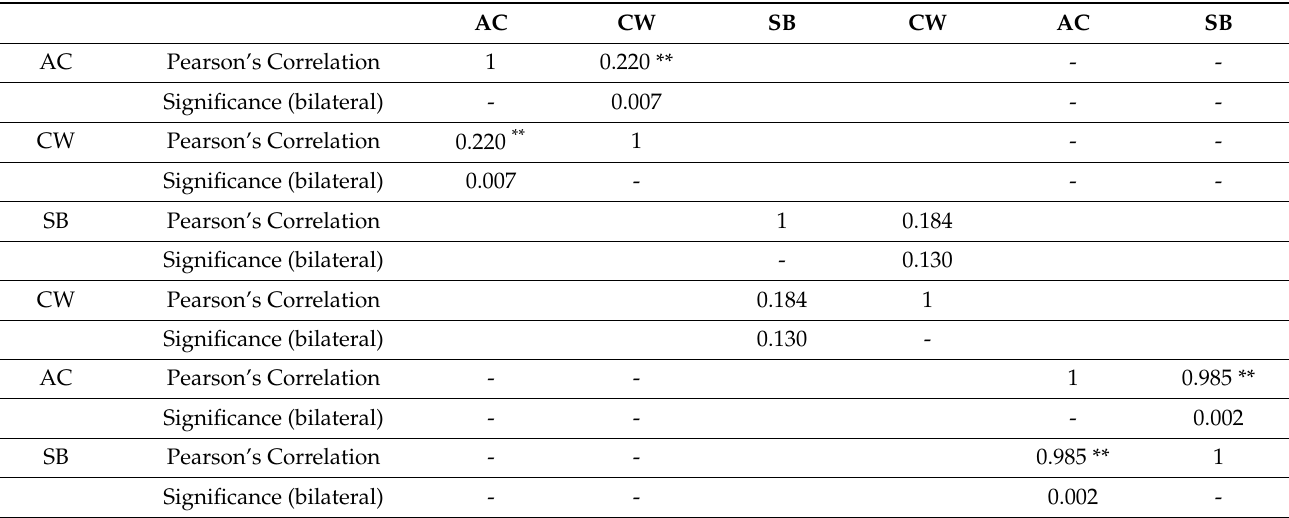
Table 6. Pearson’s correlation